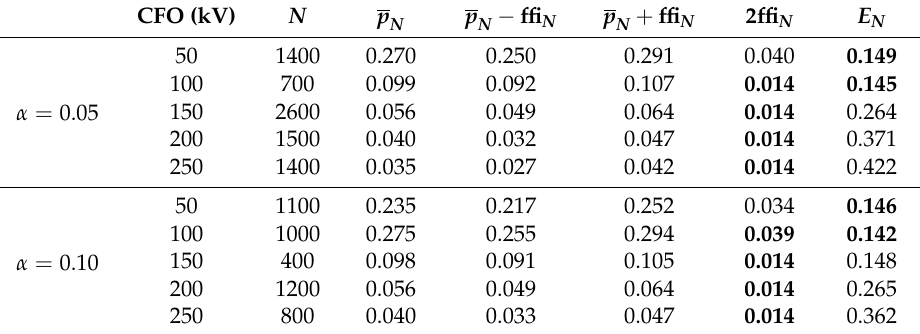
Table 3. Stopping criterion results for Test2.